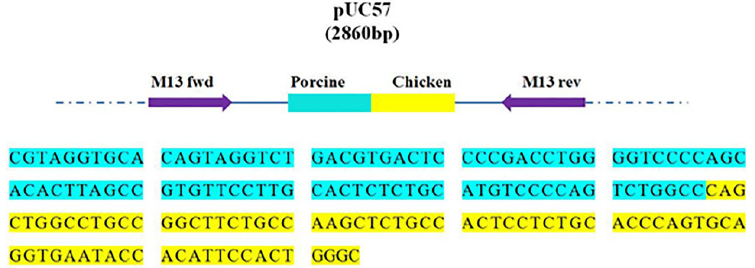
Fig 1. Porcine and chicken target DNA sequence of nucleotides and annotation of the insertion in plasmid pUC57. The plasmid was sequenced to ensure that only one copy of the porcine and chicken target DNA sequence was inserted. Inserted sequences were in line with expectations, and no deletion or insertion mutations were